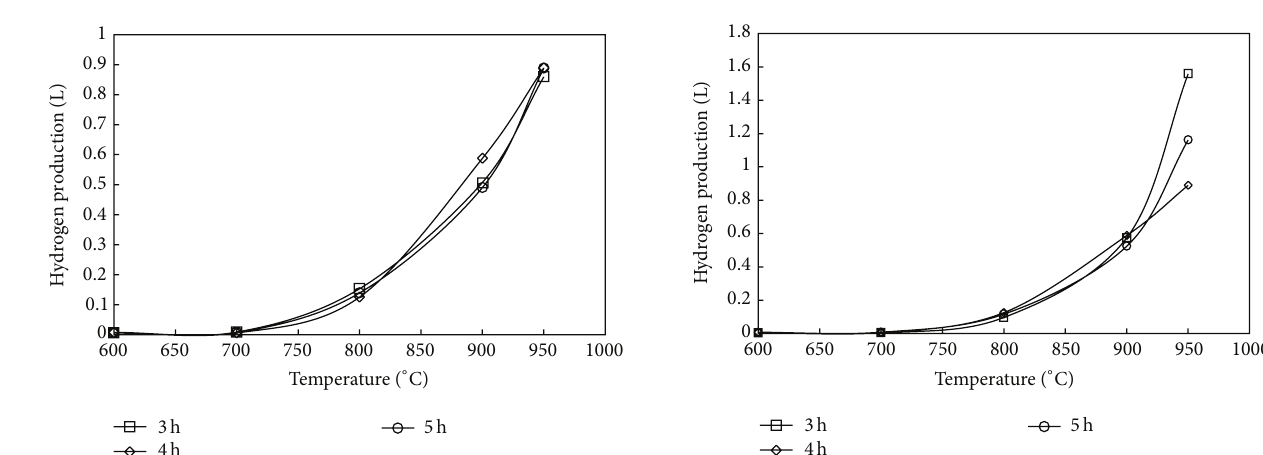
Figure 11: The XRD of different silver calcination times.